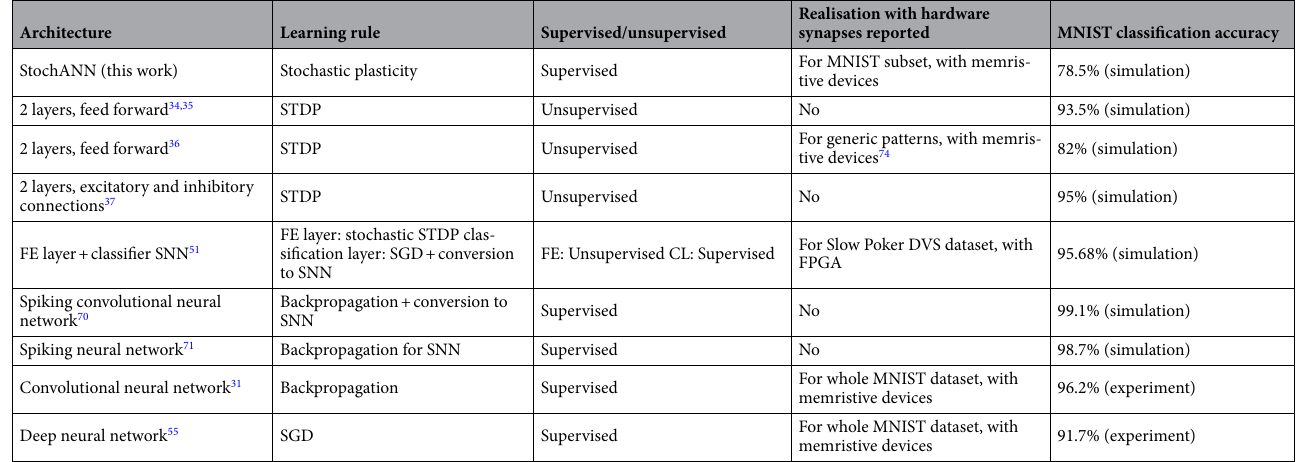
Table 2. Classification accuracy of different artificial neural network approaches on the MNIST test set. The specified accuracies (last column) are for the whole MNIST test set. Whether these are determined using simulations or experiments exploiting hardware synapses is written in